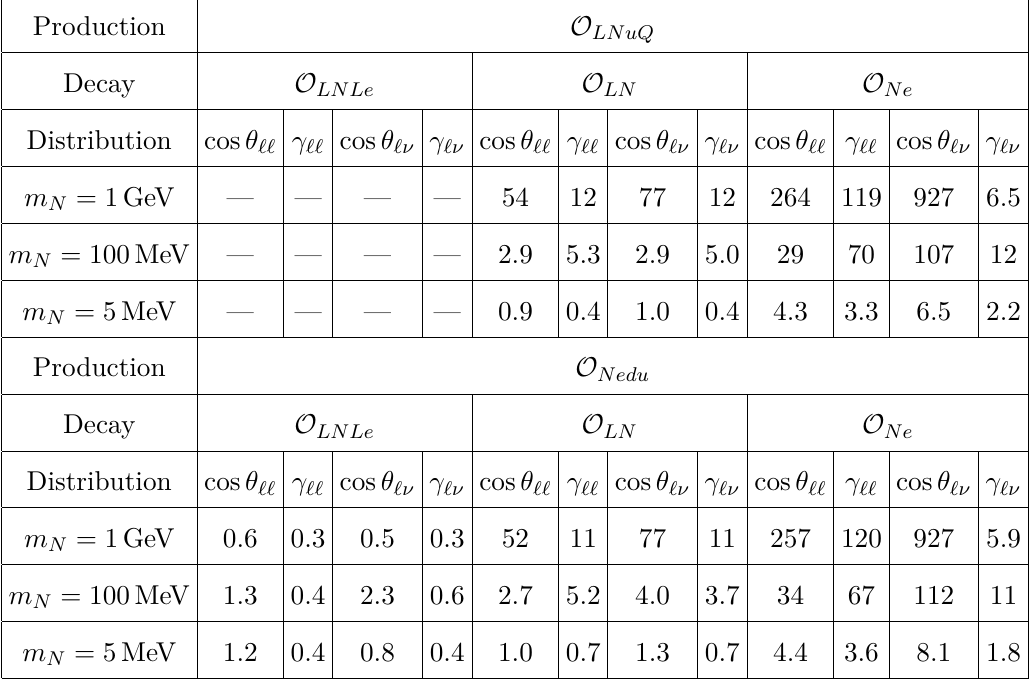
for two-body B min